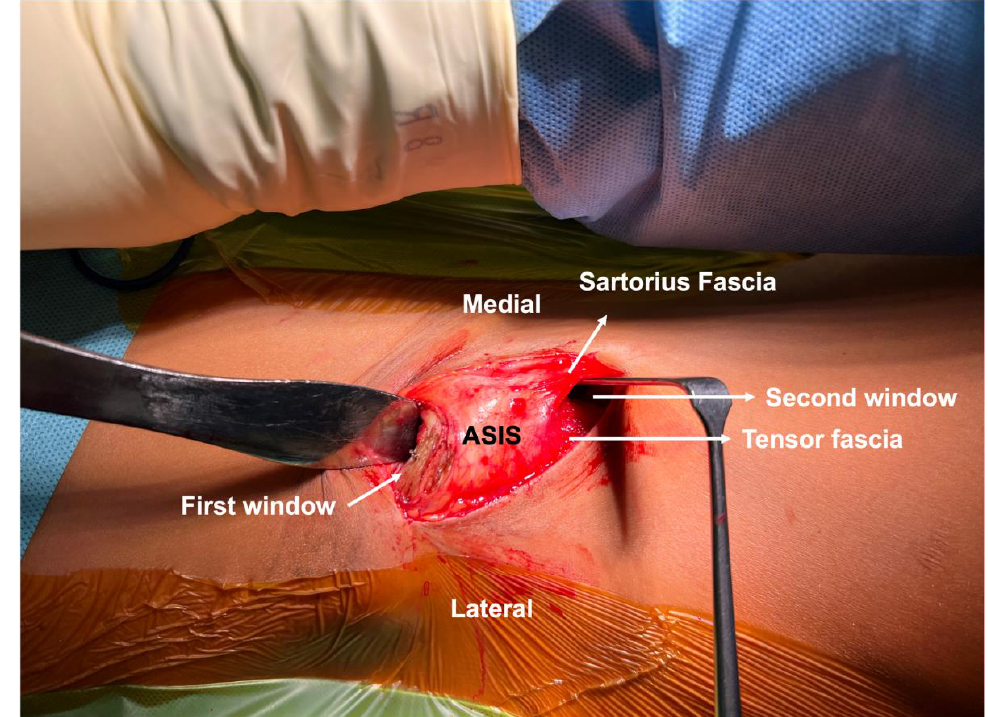
Figure 5. An intraoperative image from the surgical field depicting the Smith–Petersen approach with the two windows. The first window is developed proximally with subperiosteal insertion of a retractor beneath the iliacus muscle. The second window is developed between the Sartorius muscle and the tensor fascia lata. The two windows may be connected by mobilizing the soft tissue band from the anterior superior iliac spine (ASIS) containing the Sartorius muscle and inguinal ligament.